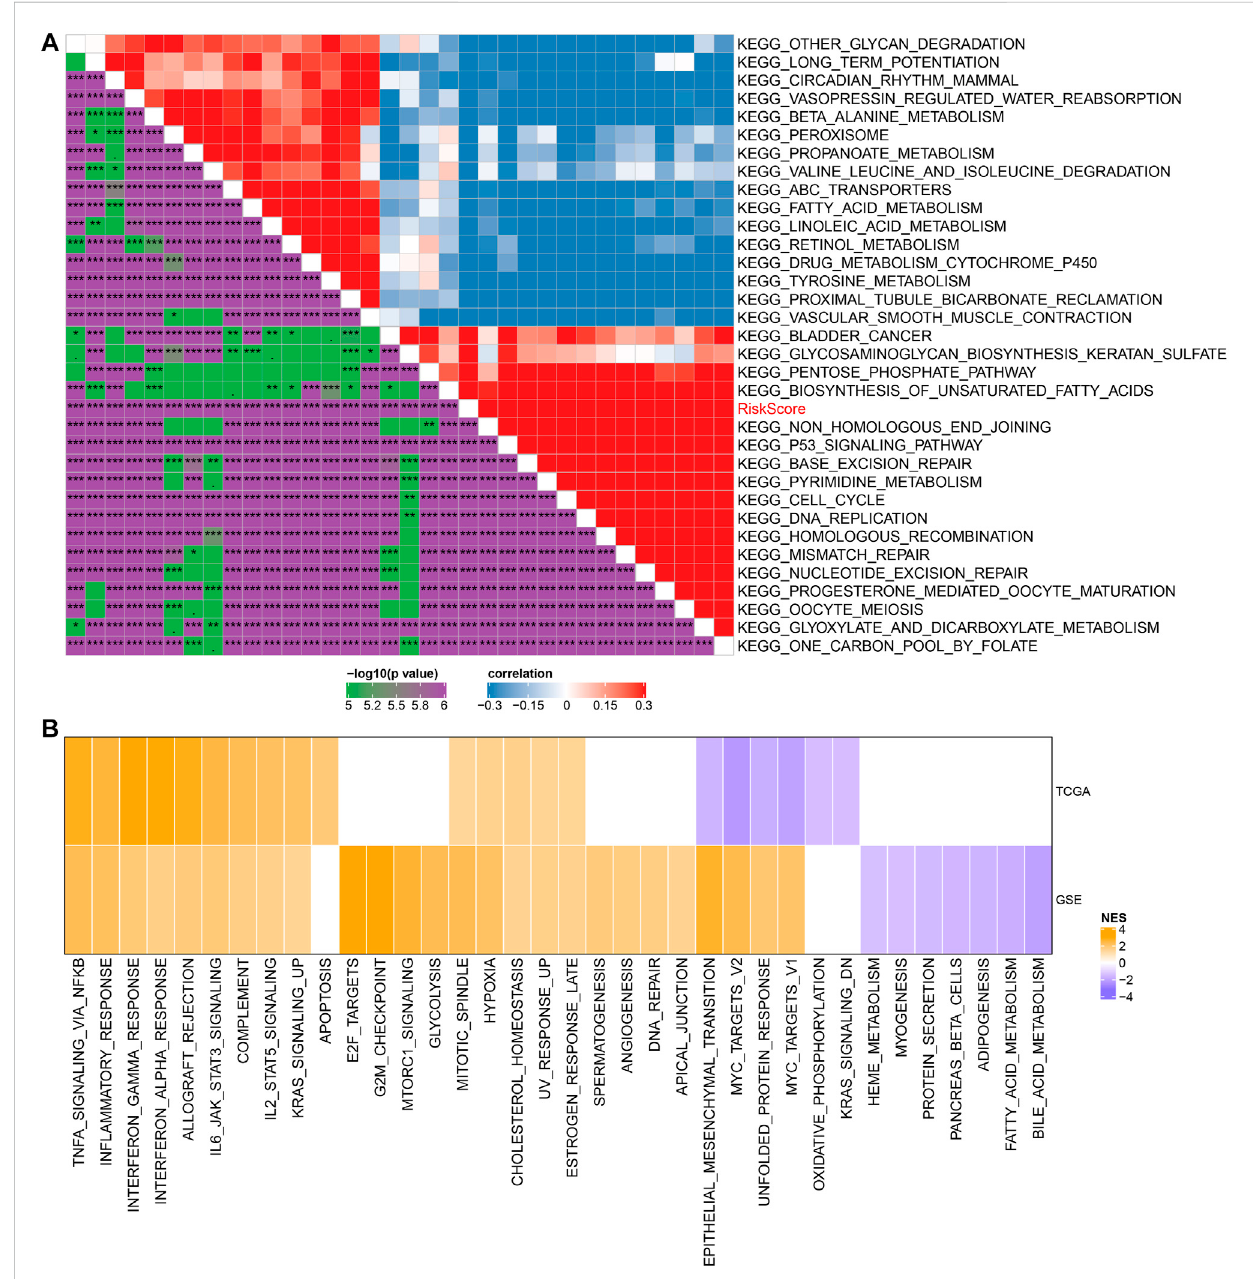
FIGURE 7 Relationship between RiskScore and KEGG pathways. (A) Heat map showing the correlation between RiskScore and KEGG pathways. (B) Heat map demonstrating normalized enrichment scores of Hallmark pathways calculated by comparing high RiskScore with low RiskScore.